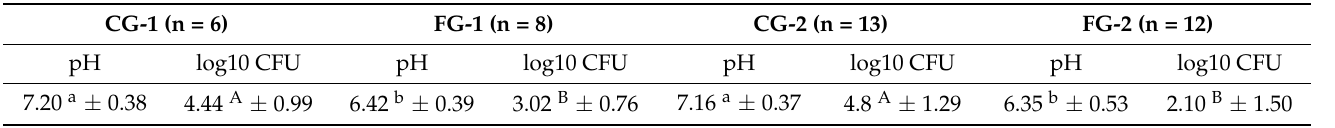
Table 9. Average number of colony-forming units of C. perfringens (log 10 CFU/g) in the faeces of the sows in the control and fibre groups taken directly post